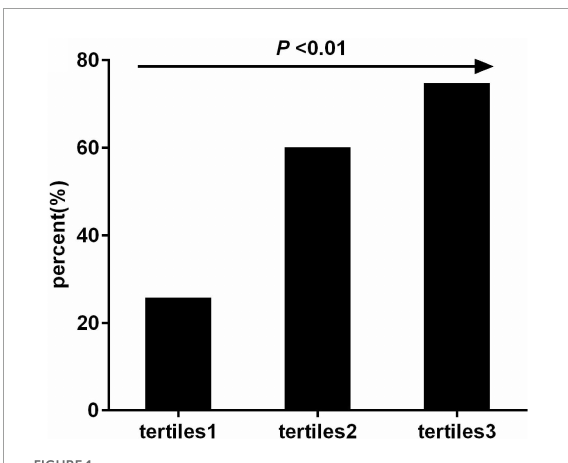
FIGURE1 Prevalence of NSCLC according to the tertiles of TyG-BMI.